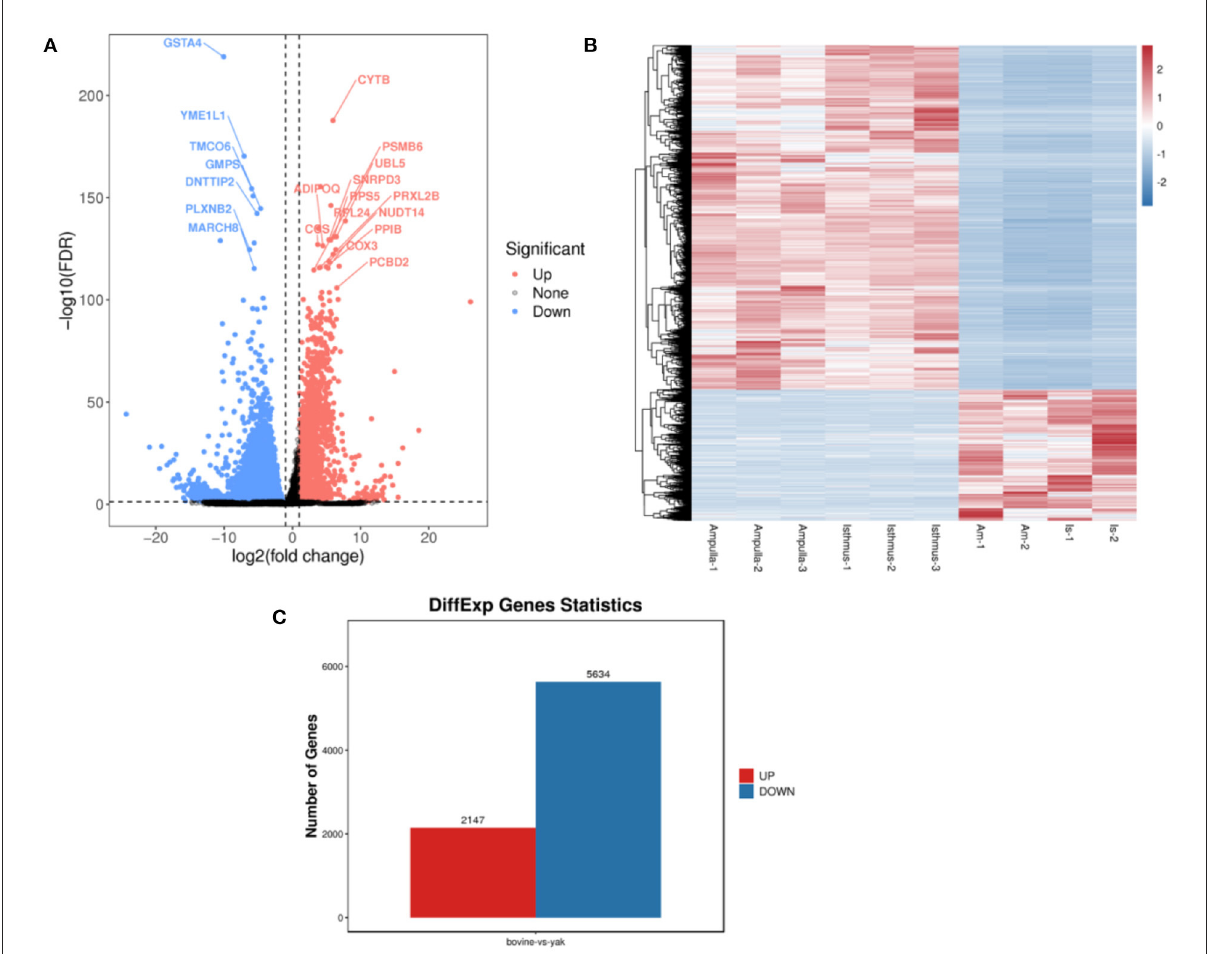
FIGURE2 Comparison of yak and bovine oviduct epithelial cells. (A) The volcano plot of DEGs. (B) The heatmap of DEGs. (C) The number of up-regulated DEGs and down-regulated DEGs.